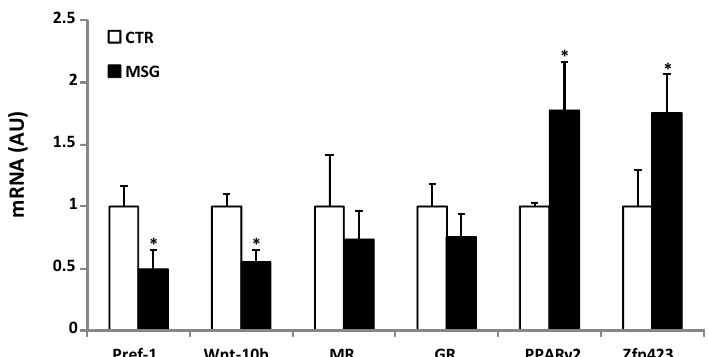
Figure 4. MSG SVF cells displayed higher competency, but lower anti-adipogenic factors expression. RPAT-SVF cell mRNA levels of anti-adipogenic (Pref-1 and Wnt-10b), glucocorticoid and mineralocorticoid receptors (GR and MR) and competency markers (PPAR- γ 2 and Zfp423) from CTR and MSG male rats (AU: arbitrary units).Values are means ± SEM ( n = 5/6 different experiments). * p < 0.05 vs. CTR values.